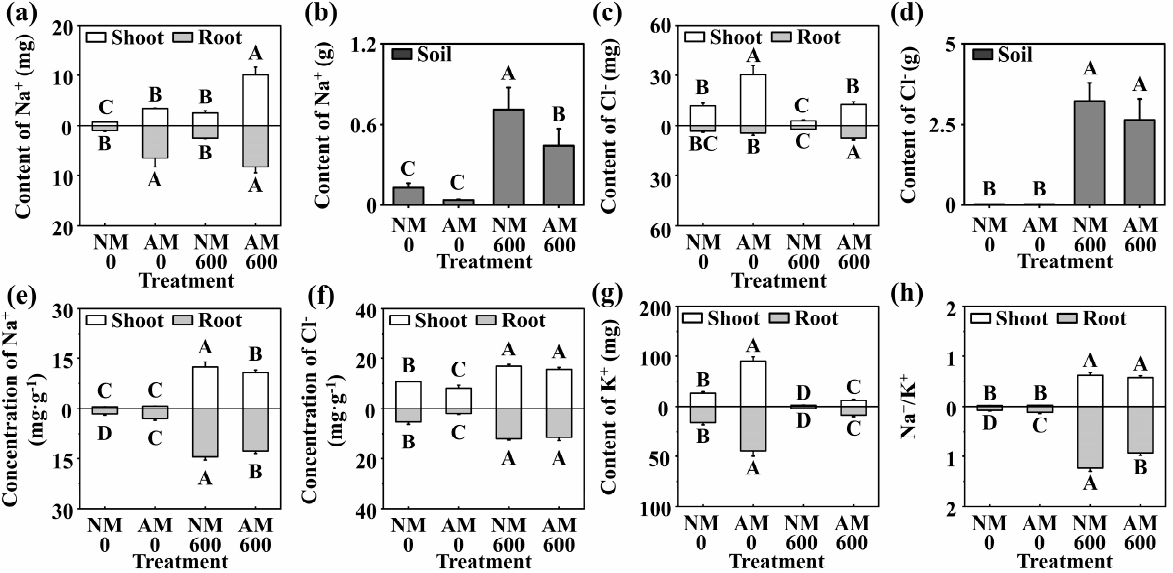
Figure 1. Effect of R. irregularis on Na + , K + , and Cl − status under NaCl stress. ( a ) The content of Na + in C. glauca . ( b ) The content of Na + in soil. ( c ): The content of Cl − in C. glauca . ( d ) The content of Cl − in soil. ( e ) The concentration of Na + in C. glauca . ( f ) The concentration of Cl − in C. glauca . ( g ) The content of K + in C. glauca . ( h ) The Na + /K + of C. glauca . NM, nonmycorrhizal; AM, inoculated with R. irregularis ; 0, no NaCl stress; 600, 600 mM NaCl stress. The data are the means ± standard errors ( n = 3). Different capital letters indicate significant differences between means at the p < 0.05 level by Tukey’s test. Data of roots from Wang et al. [31] in the same project.